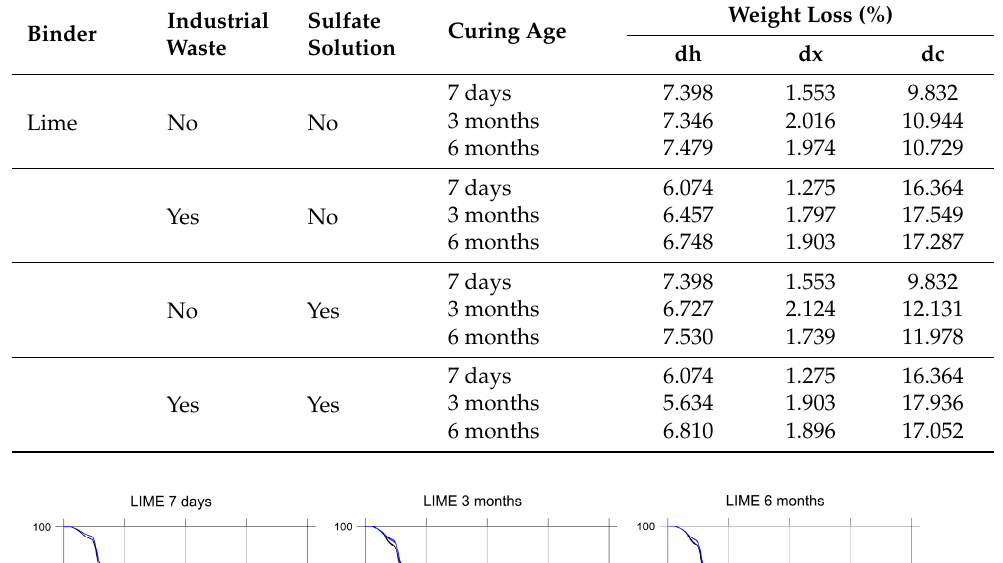
Table 4. Relative values from DTA-TG tests for cement samples. Table 3. Relative values from DTA-TG tests for lime samples.